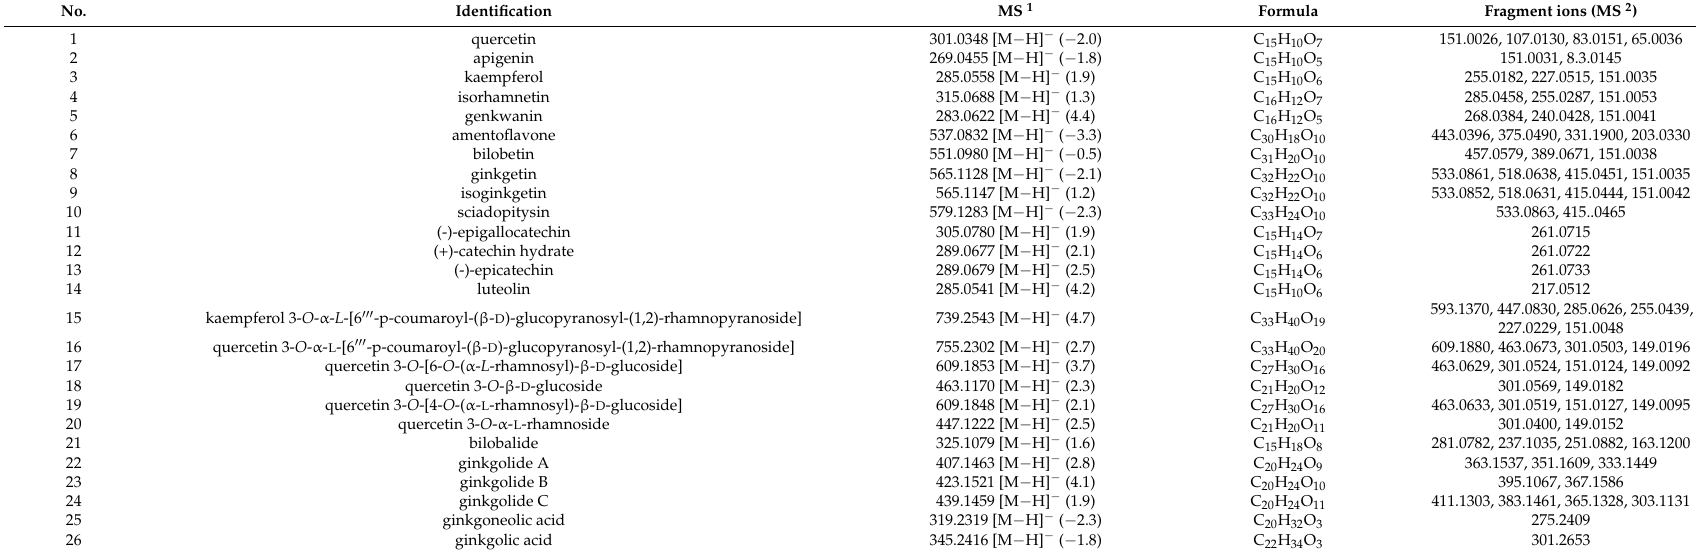
Table 1. Q/TOF–MS data obtained in electrospray ionization source (ESI − ) mode of flavonoids, ginkgolides and